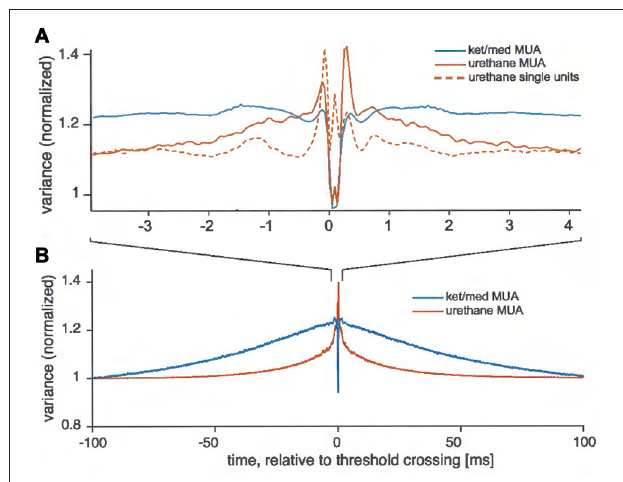
FIGURE 3 | Variance of voltage around threshold crossings. Traces show the variance of the voltage around extracted events used for spike sorting at single sites of the tetrodes, normalized by the mean variance for each recording obtained at random points in time for each recording. (A) For ketamine/medotomidine (ket/med) anesthesia, only unsortable traces (i.e., multi-unit activity) are shown (MUA, blue solid line). For urethane anesthesia, events were split into those with successful extraction of a single unit (single units, red dotted line) and those which could not successfully be assigned to a single unit (MUA, red solid line). (B) Variance around threshold crossings on a longer time scale.